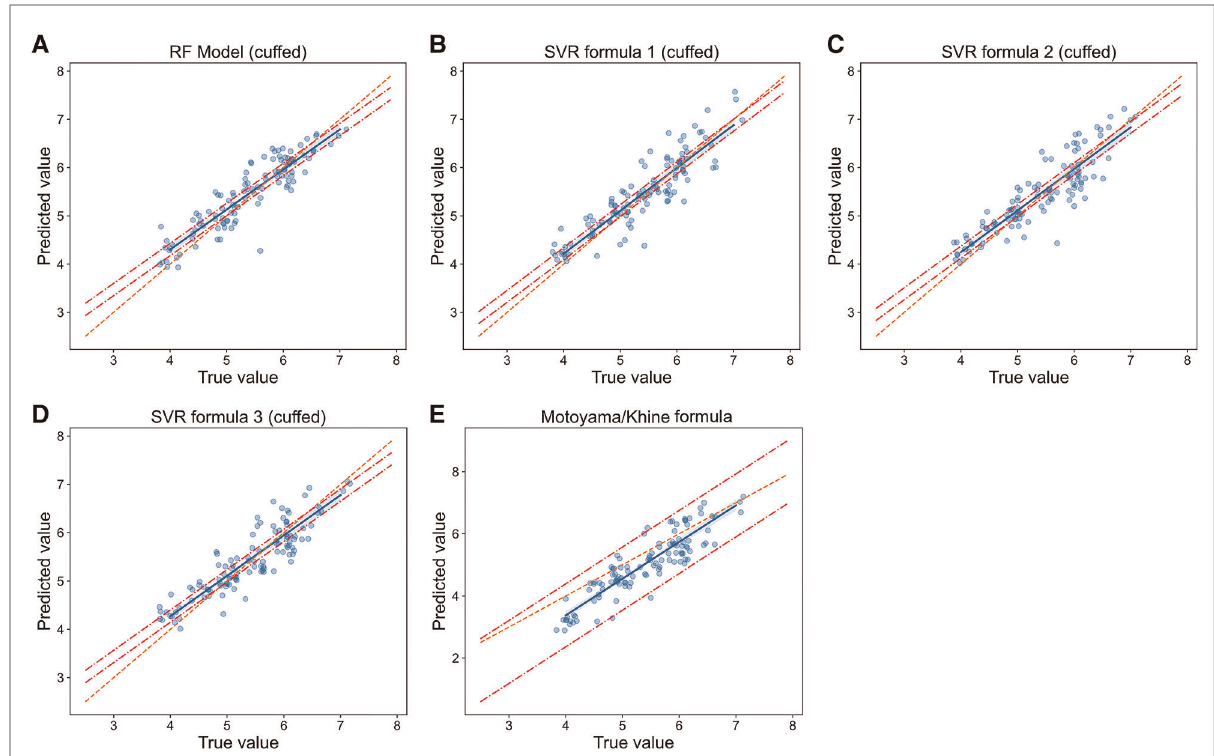
FIGURE 6 Relationship of predicted values and true values in cuffed ETT size prediction (model vs. Formulas). The scatter plots show the relationship of optimal ETT size (x-axis) vs. predicted ETT size (y-axis) for cuffed ETT size prediction with RF model ( A ), SVR formulas (B-D) and Motoyama/ Khine formula ( E ). The blue line represents the linear regression line, and the orange line represents the standard line of absolutely accuracte prediction. The area between the two red dashed lines represents the 95% CI (con fi dence interval). RF=random forest, SVR=support vector